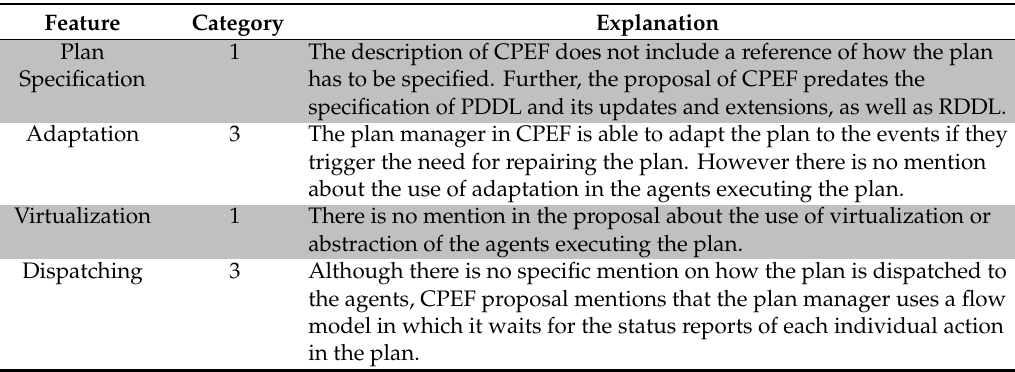
Table 10. CPEF assessment.